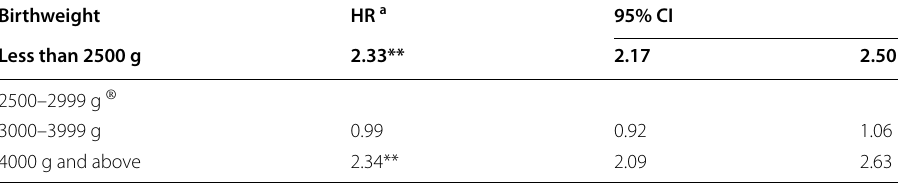
HR, hazard ratio; CI, confidence interval; ** p ‑values < 0.01 and * 0.01 < p‑values < 0.05 a Adjusted for maternal characteristics viz. age at first birth, level of schooling, marital status, wealth status, religion, caste and child characteristics viz. sex, type of birth, birth order, previous birth interval, mode of delivery, assistance